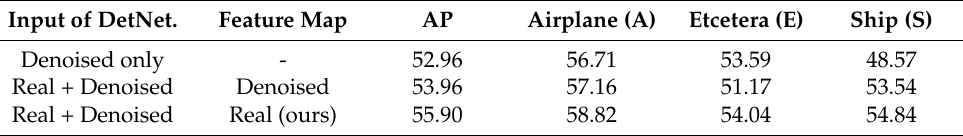
Table 3. Ablation study across the input type of detection network and feature map forwarded to subsequent sub-network for classification and bounding box regression for each RoIs. The entries with the best APs for each object category are highlight in bold. The backbone is ResNet-50-FPN. Input of